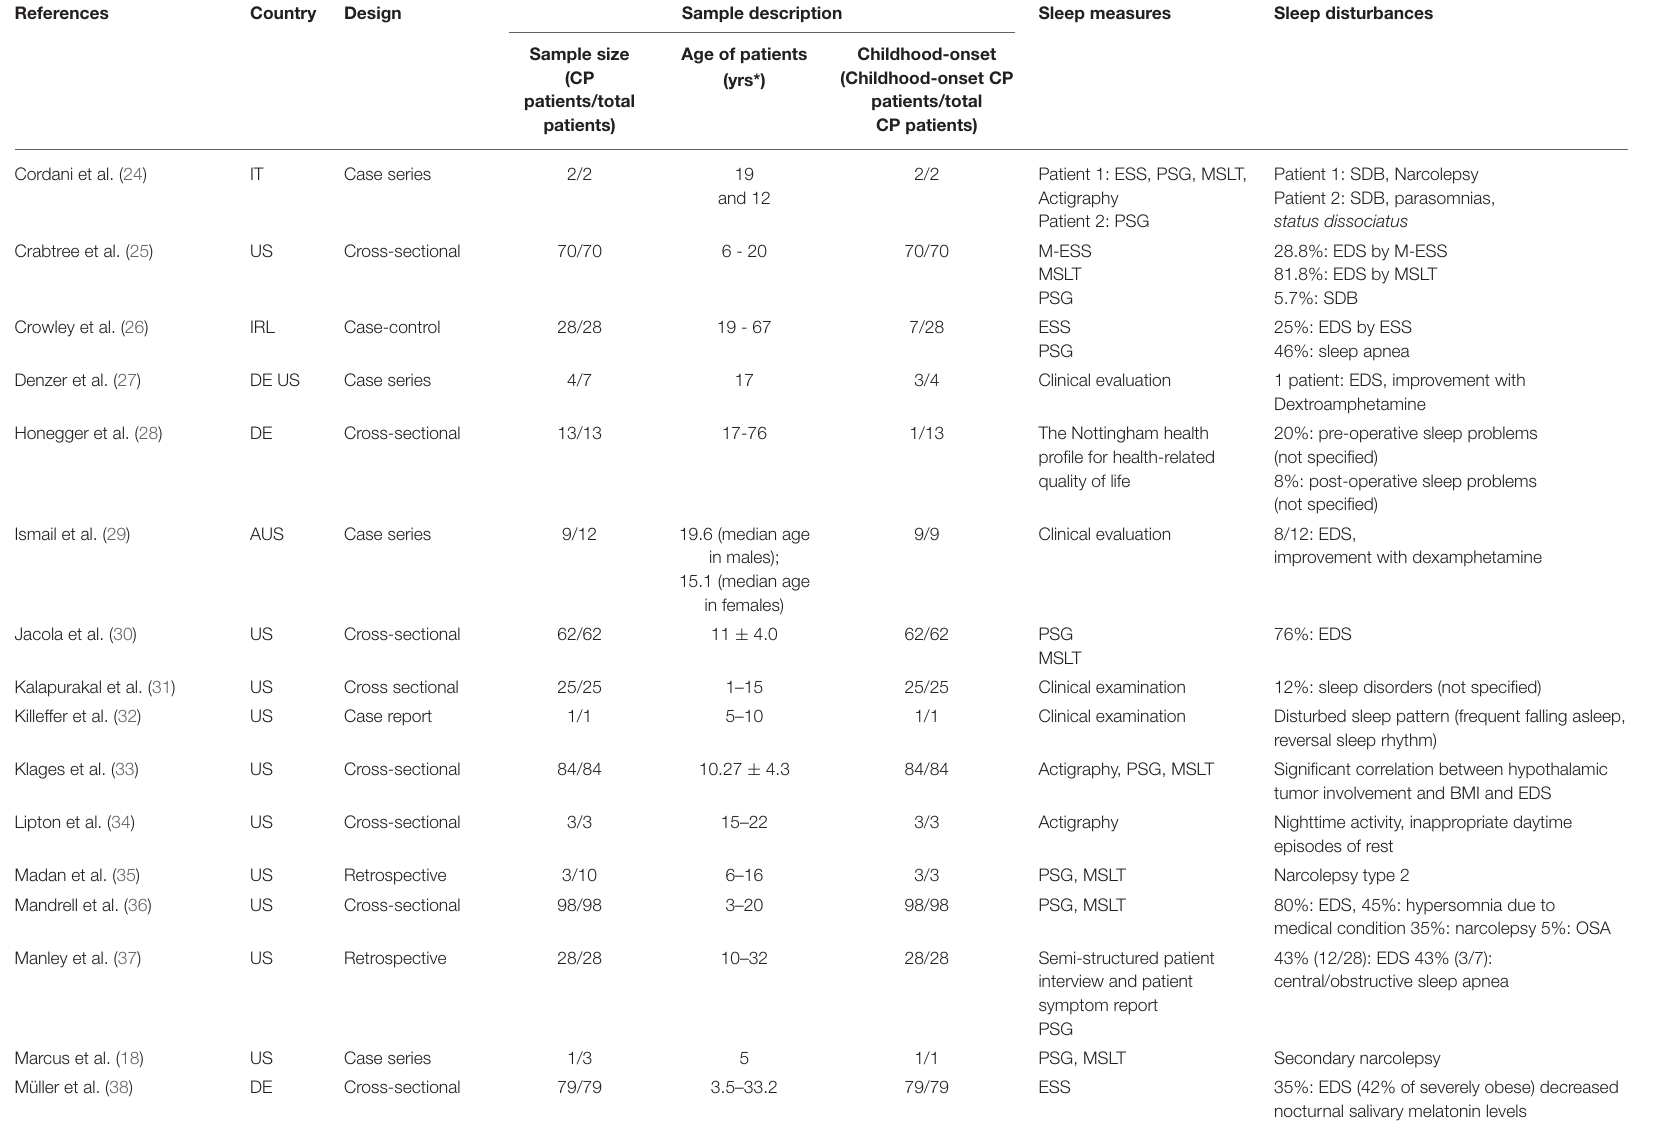
TABLE 1 | Main characteristics of the studies included in the